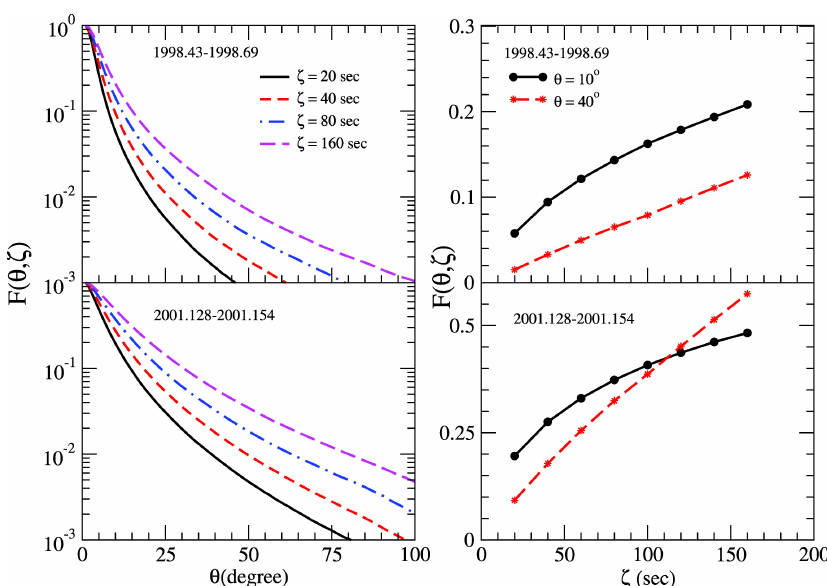
Figure 105: Distribution function for two time periods. The left panels show the dependence of 𝐹 ( 𝜃, 𝜁 ) on 𝜃 , and the right panels show the dependence of 𝐹 ( 𝜃, 𝜁 ) on 𝜁 . The presence of a current sheet makes 𝐹 ( 𝜃, 𝜁 ) to increases linearly with 𝜁 (dashed lines in the right panels). Image reproduced by permission from Li (2008), copyright by